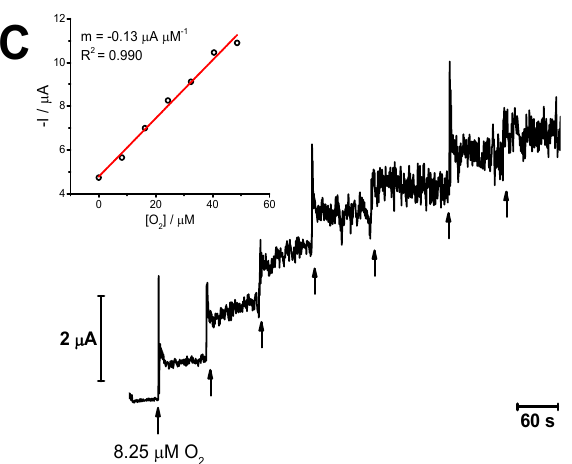
Figure 6. Electrochemical behavior of O 2 reduction at the depth probe surface. ( A ) Average sensitivity as a function of the applied potential, obtained from calibration of 4 sites in PBS. ( B ) Average baseline current as a function of the applied potential, obtained in N 2 -purged PBS. ( C ) Representative calibration obtained at − 0.6 V vs. Ag / AgCl and the calibration curve (inset) of a single recording site of the Integra probe. n = 4.